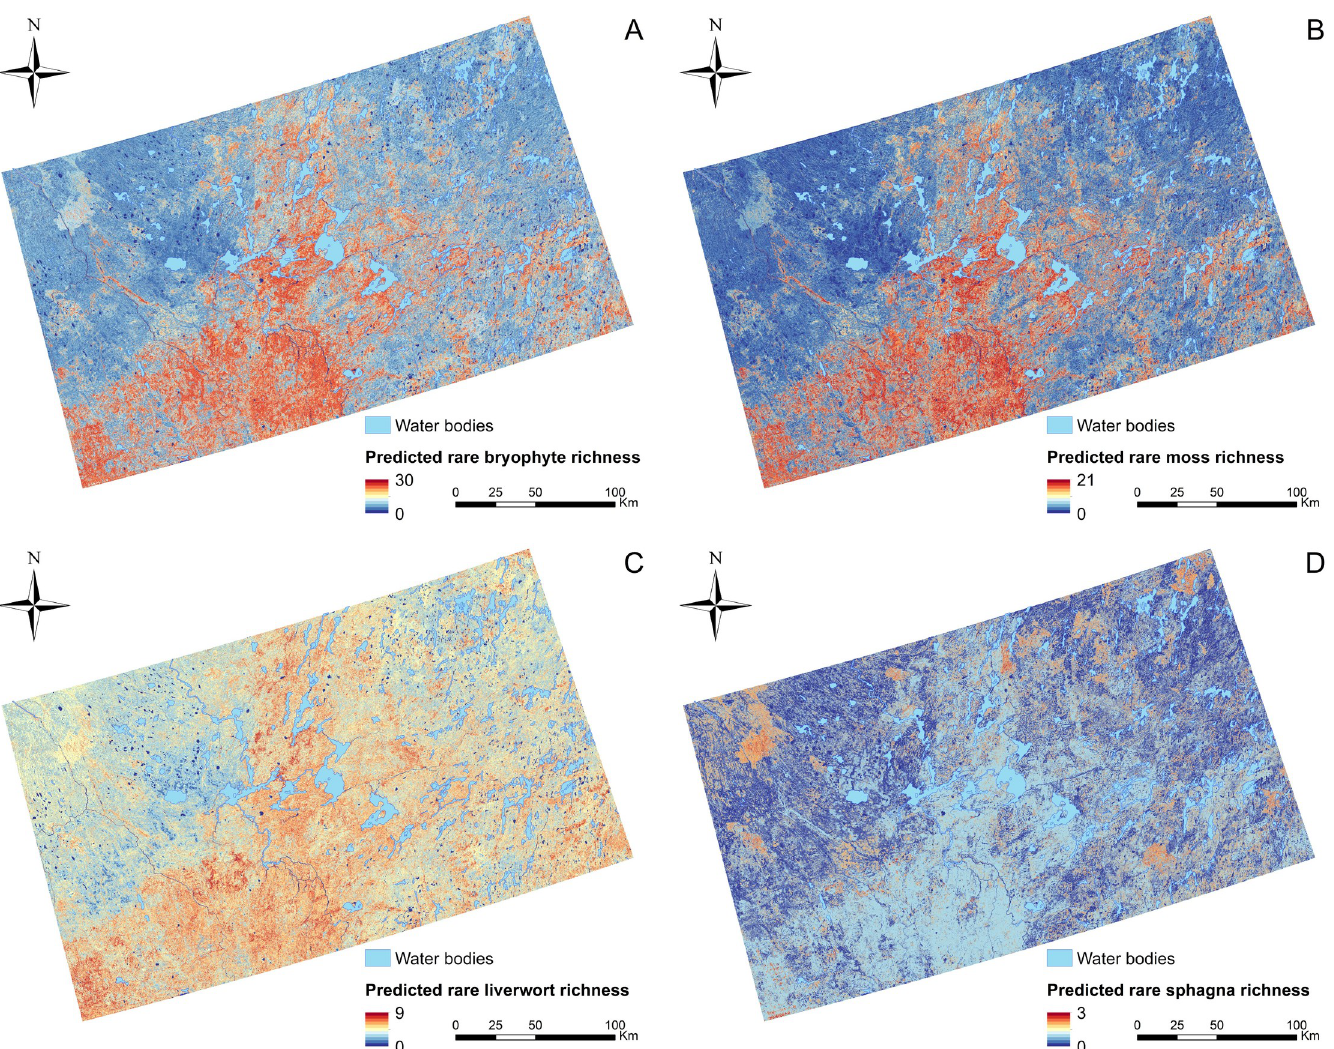
Fig 4. Mapping of (A) total rare bryophyte, (B) rare moss, (C) rare liverwort, and (D) rare sphagna richness (species number) for the study area at 30 m resolution. Computed from stacked predicted rare species